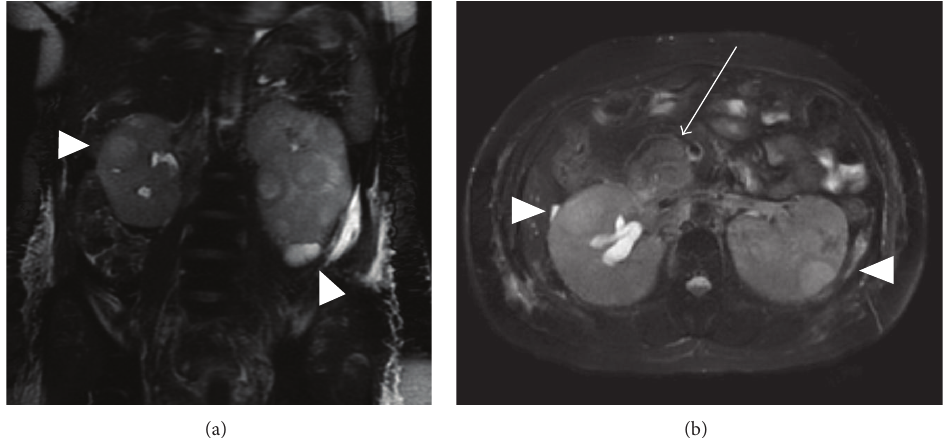
Figure 1: Magnetic resonance imaging of the abdomen showing bilateral renal infiltration. T2-weighted fat-saturated magnetic resonance imaging of the abdomen. (a) Coronal view shows bilateral renal infiltration (arrowheads). (b) Transverse cross-section shows bilateral renal infiltration (arrowheads), unilateral right hydronephrosis, and pancreatic involvement (arrow).